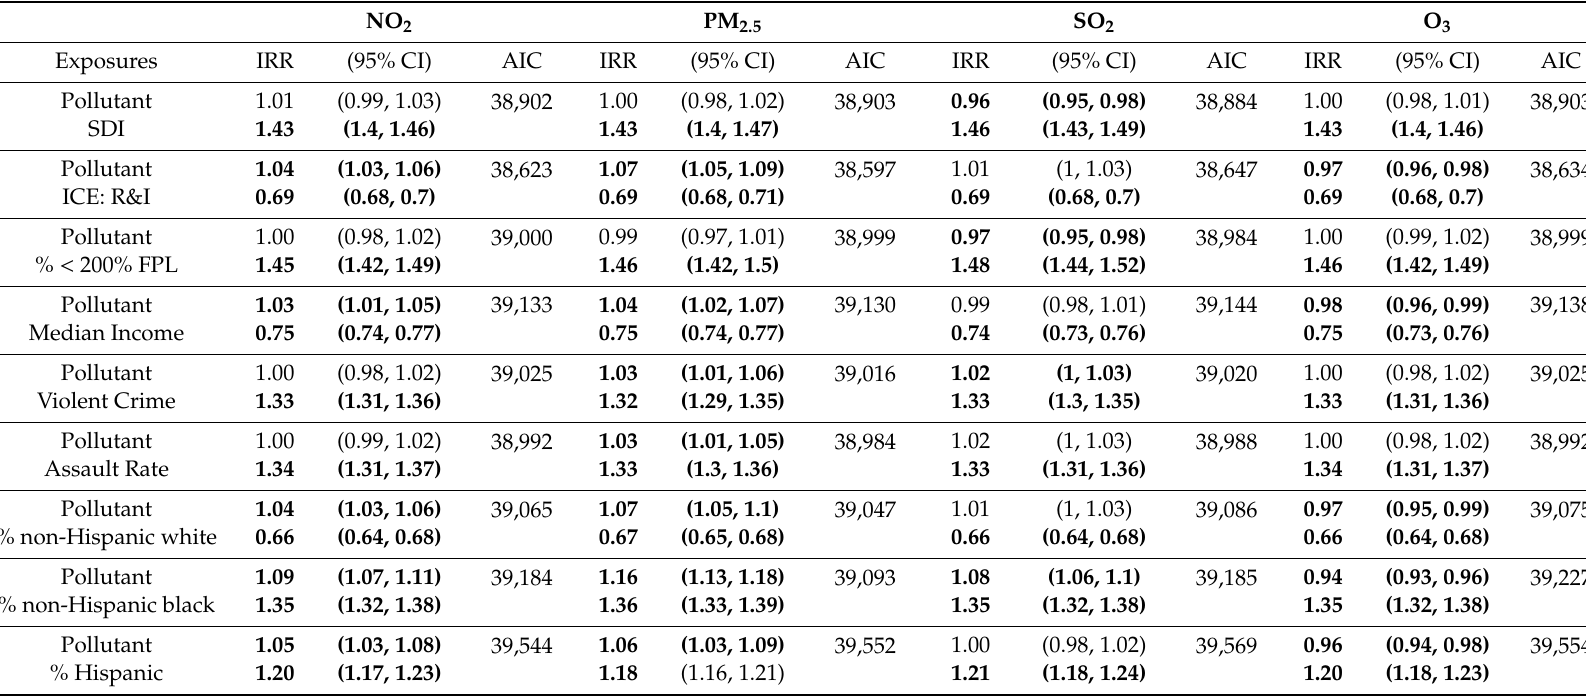
Table 4. Mutually-adjusted negative binomial models for each pollutant-social factor combination, vs. census tract CVD incidence rate. Incident rate ratio (IRR) represents the change in CVD incidence rate per 1-IQR change in each covariate. Bolded values indicate statistical significance after adjusting for the false discovery rate. N =